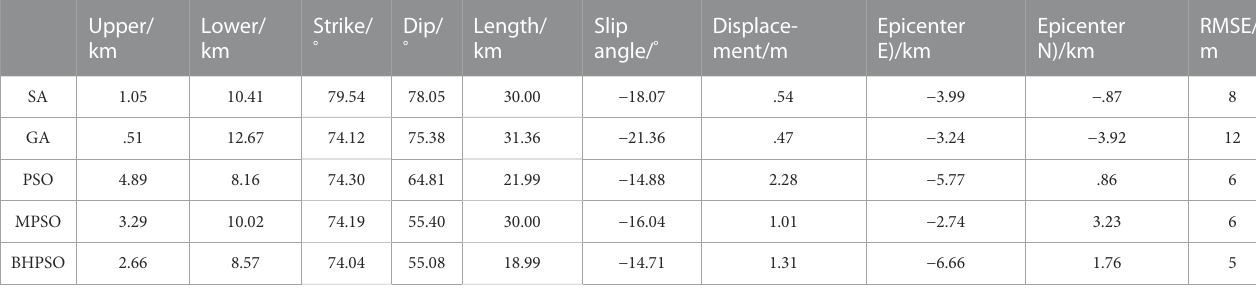
TABLE 5 The inversion results of fault parameters for the Nevada